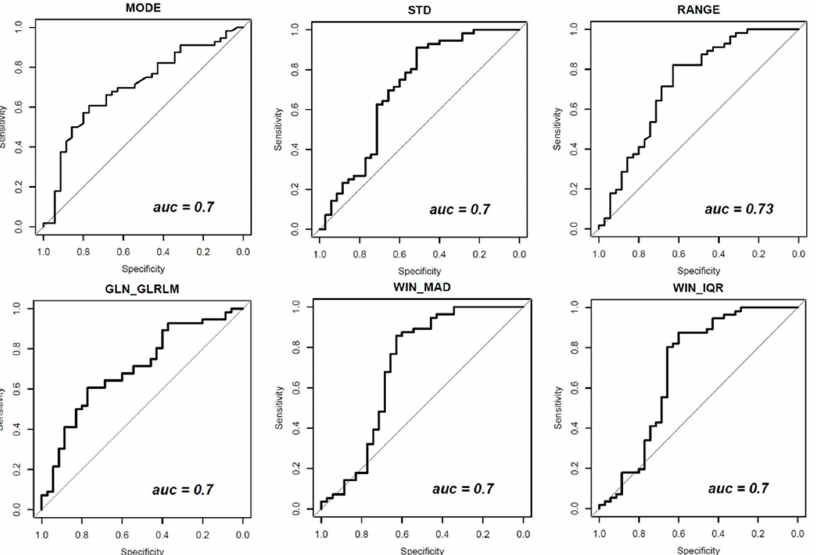
Figure 2. Receiver operating characteristic (ROC) curves of significant textural and dynamic features with AUC values.